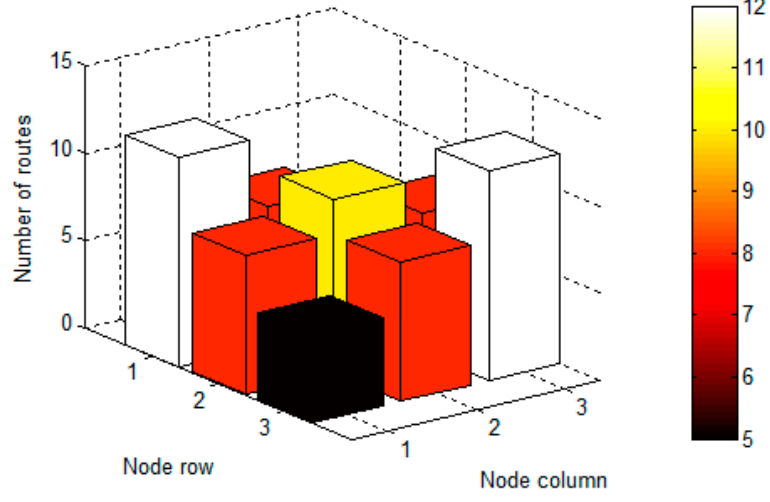
Figure 11. Number of routes passing through each node in a 3 × 3 PWMNS.